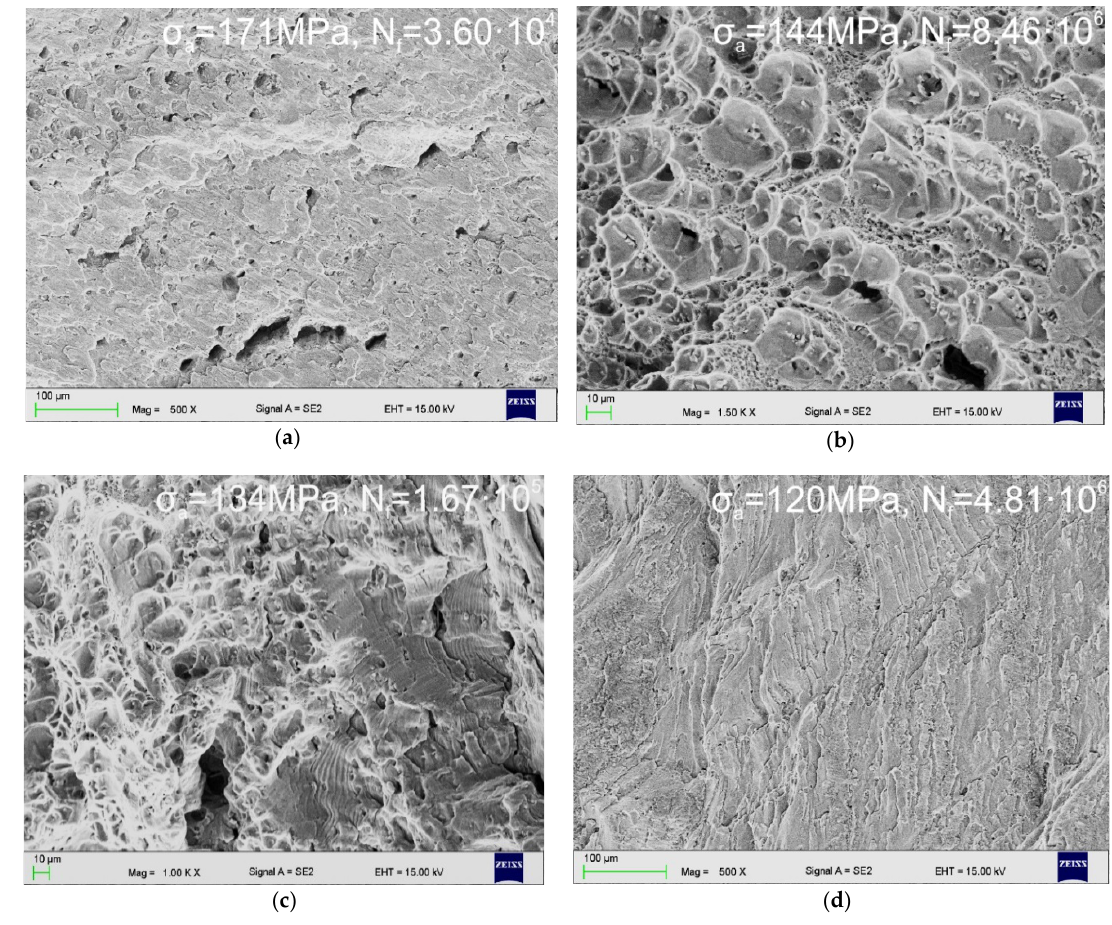
Figure 8. ( a ) Quasi - cleavage nature of fatigue fracture of the alloy ; ( b ) Ductile fracture areas with precipitates on the bottom of cracks ; ( c ) A mixed nature of scrap and fatigue striae on cleavage islands ; ( d ) Cleavage planes tongue - like steps.